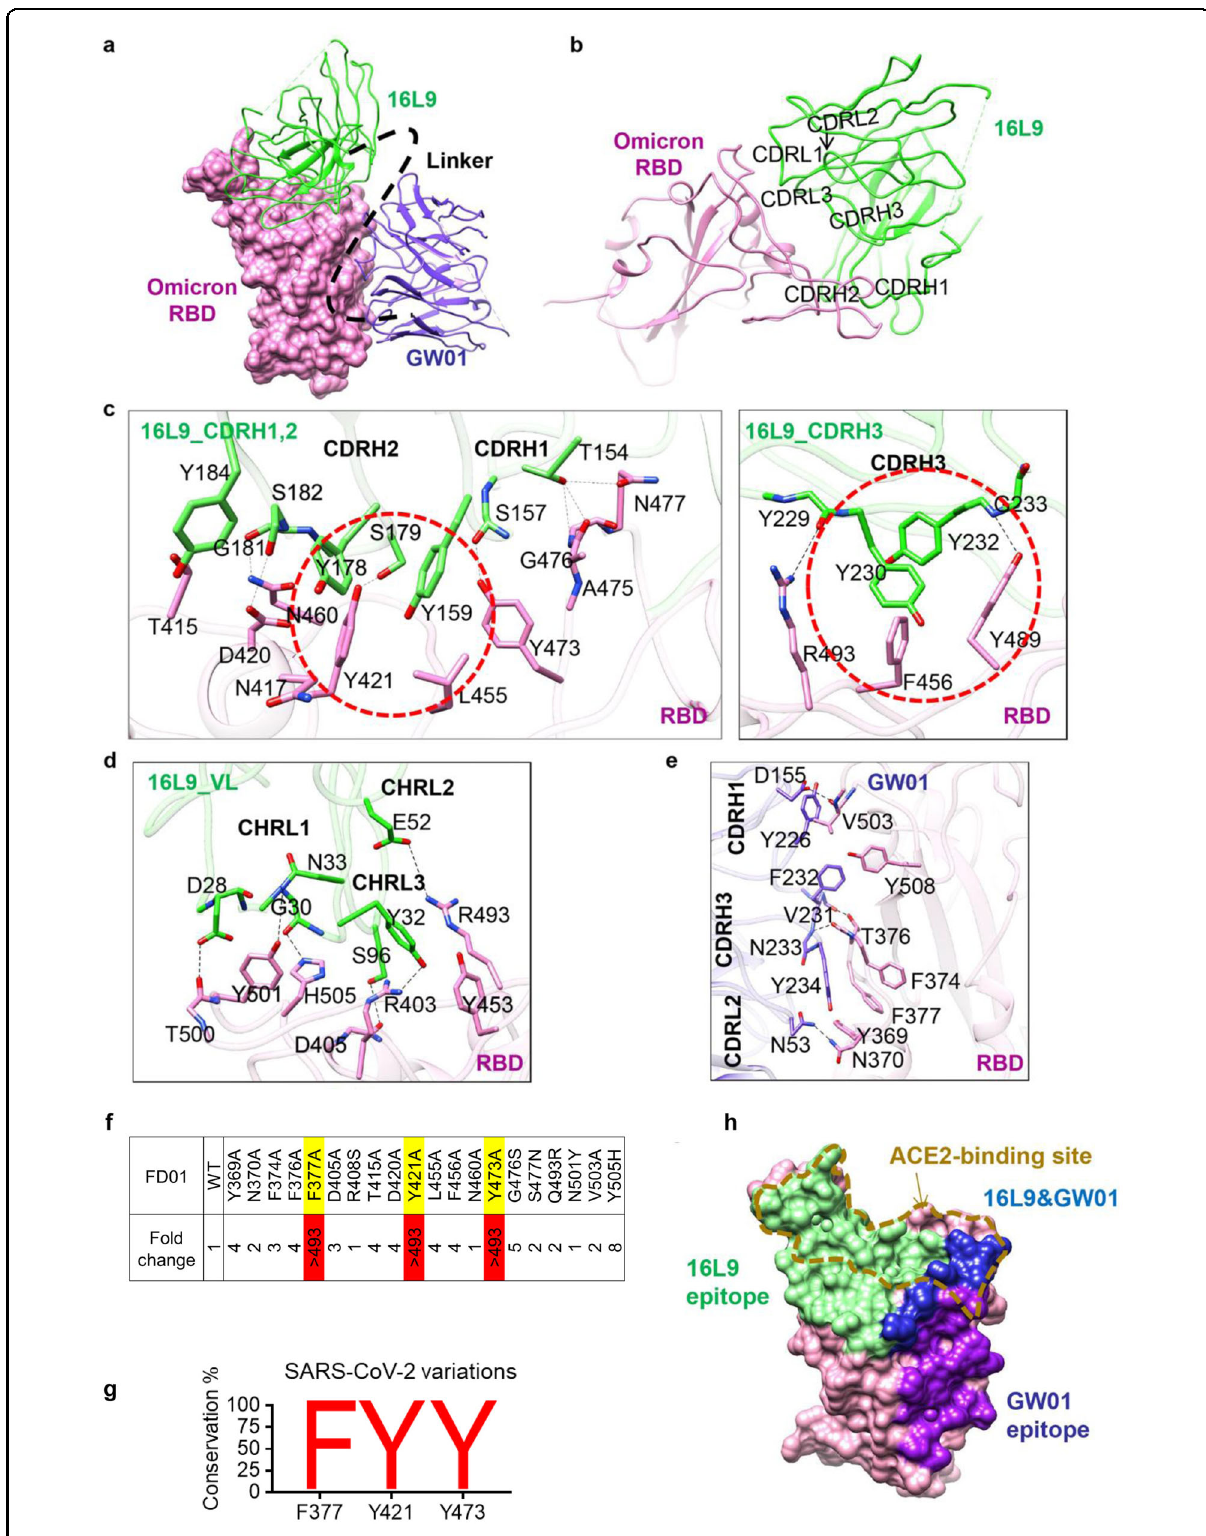
Fig. 5 (See legend on next